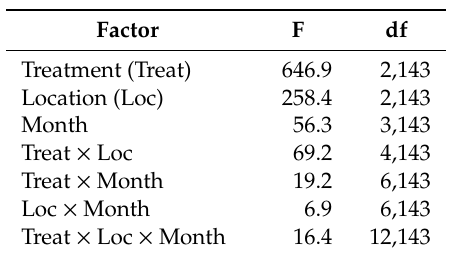
Table 1. Overall ANOVA (Proc Mixed, Statistical Analysis System, Version 9.4), live larvae after five days, for main e ff ects treatment (untreated controls and the two deltamethrin rates), location where arenas were held (outside, shed, or lab), and month post-treatment (0, 1, 2, or 3). All main e ff ects and interactions significant at p < 0.001.